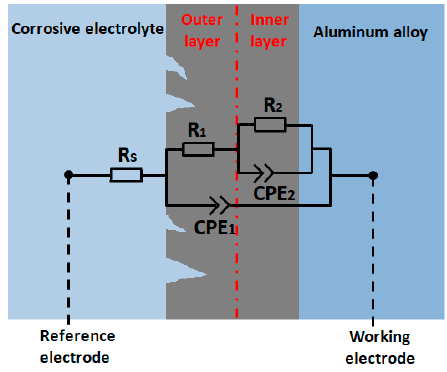
Figure 9. Equivalent circuit model related to the electrochemical impedance spectroscopy (EIS) plots for analyzing the corrosion behavior of the